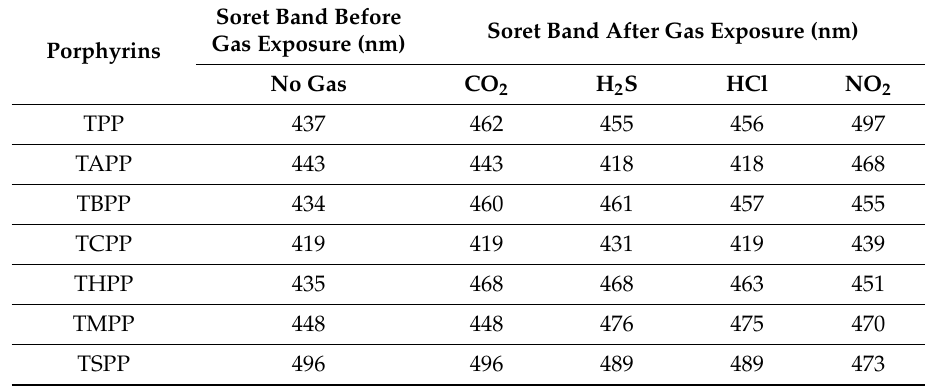
Table 3. Maximum wavelength of each band of each porphyrin after gas exposure (10,000 ppm). No Gas CO Soret Band Before Soret Band After Gas Exposure (nm) Gas Exposure(nm) Porphyrins